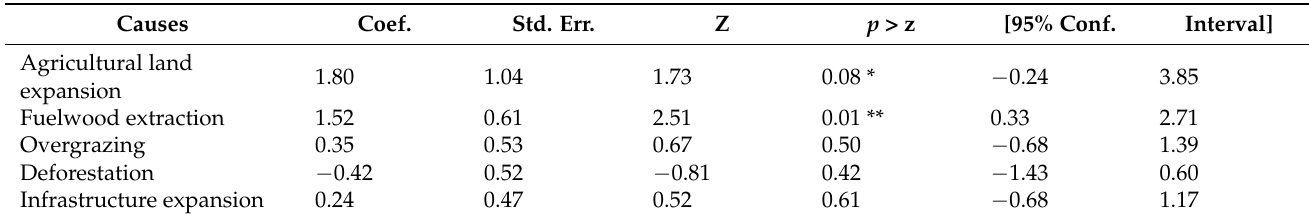
Table 6. The proximate causes of LULCC based on logit regression